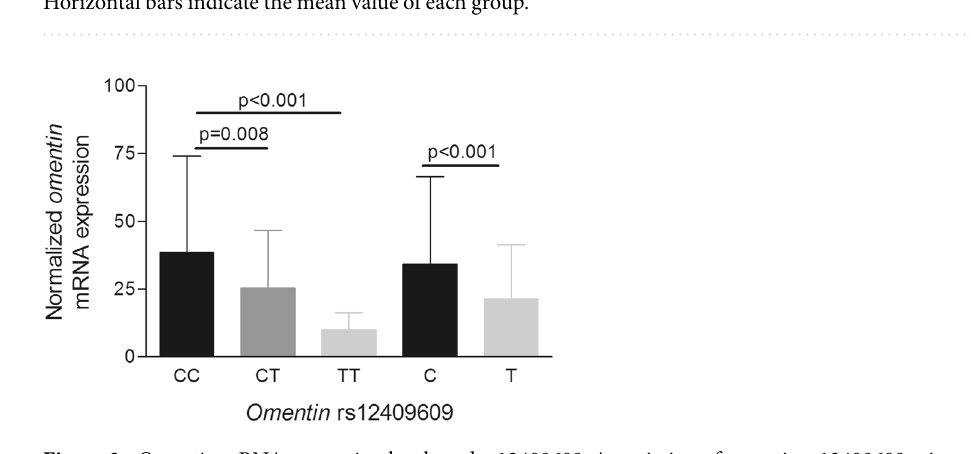
Figure 3. Omentin mRNA expression levels and rs12409609. Association of omentin rs12409609 minor (T) allele with low omentin mRNA expression in axSpA patients, both when genotypes and alleles were assessed. p-values displayed were obtained after adjustment for potential confounding